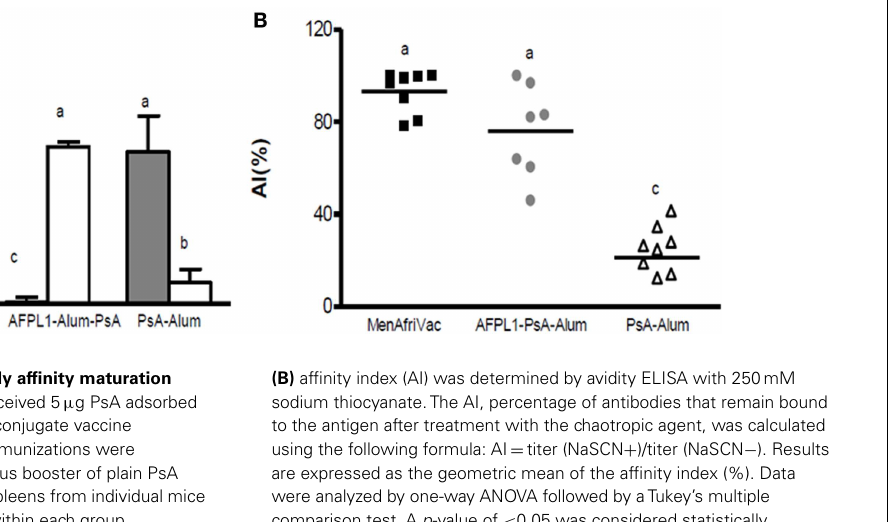
(B) affinity index (AI) was determined by avidity ELISA with 250mM sodium thiocyanate.The AI, percentage of antibodies that remain bound to the antigen after treatment with the chaotropic agent, was calculated using the following formula: AI = titer (NaSCN + )/titer (NaSCN − ). Results are expressed as the geometric mean of the affinity index (%). Data were analyzed by one-way ANOVA followed by aTukey’s multiple comparison test. A p -value of < 0.05 was considered statistically significant and is represented by different